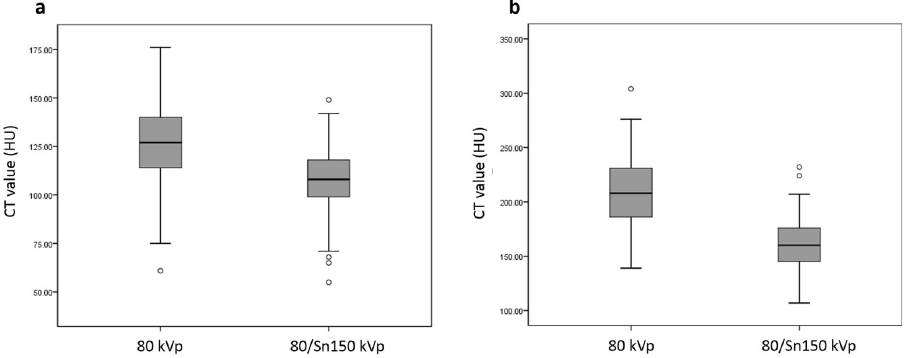
Fig 2. Box and whisker plots of CT enhancement. Difference in the liver parenchyma (a) and abdominal aorta (b) between 80 kVp and 80/Sn150 kVp CT. Box-and-whisker diagrams show mean values ± standard deviation, as well as minimum and maximum